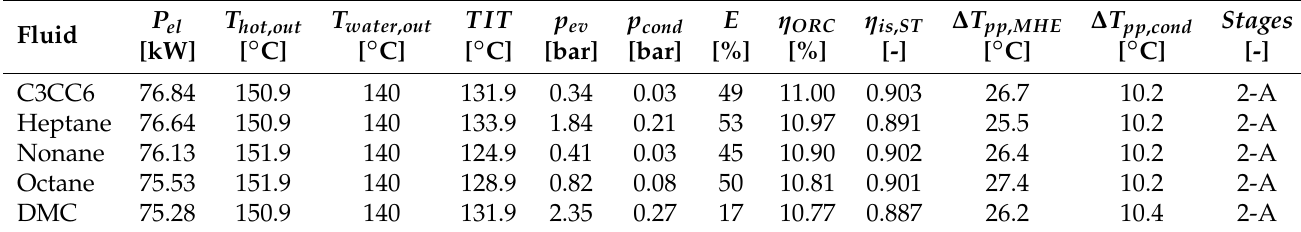
Table A8. Most promising fluids in the case of adopting an ORC and a water